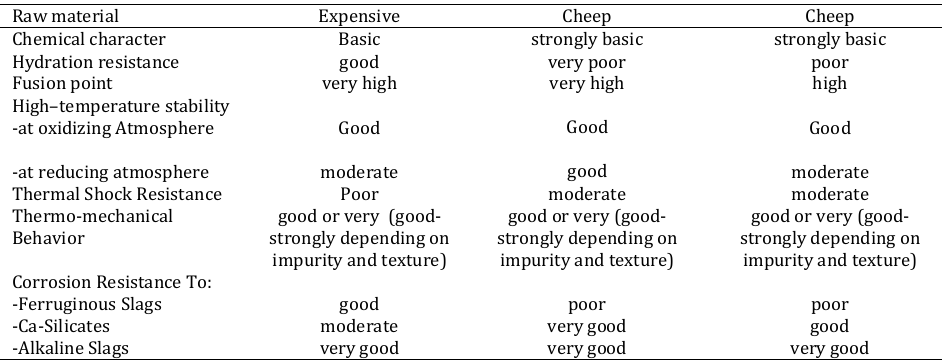
Table 1. Compare properties of MgO, CaO and MgO-CaO refractories